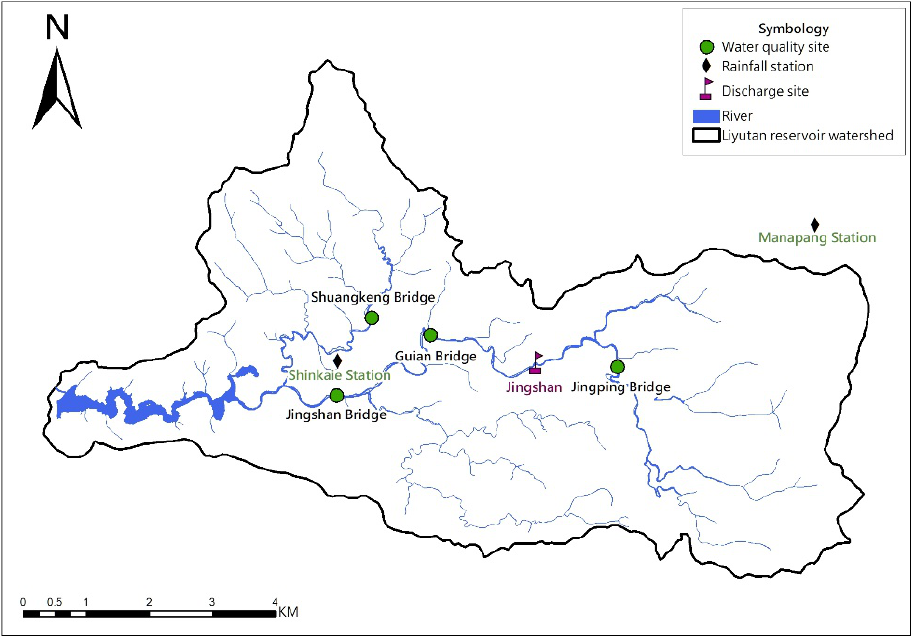
Figure 4. The o ffi cial flow station and water quality monitoring sites in the Figure 4. The official flow station and water quality monitoring sites in the watershed.